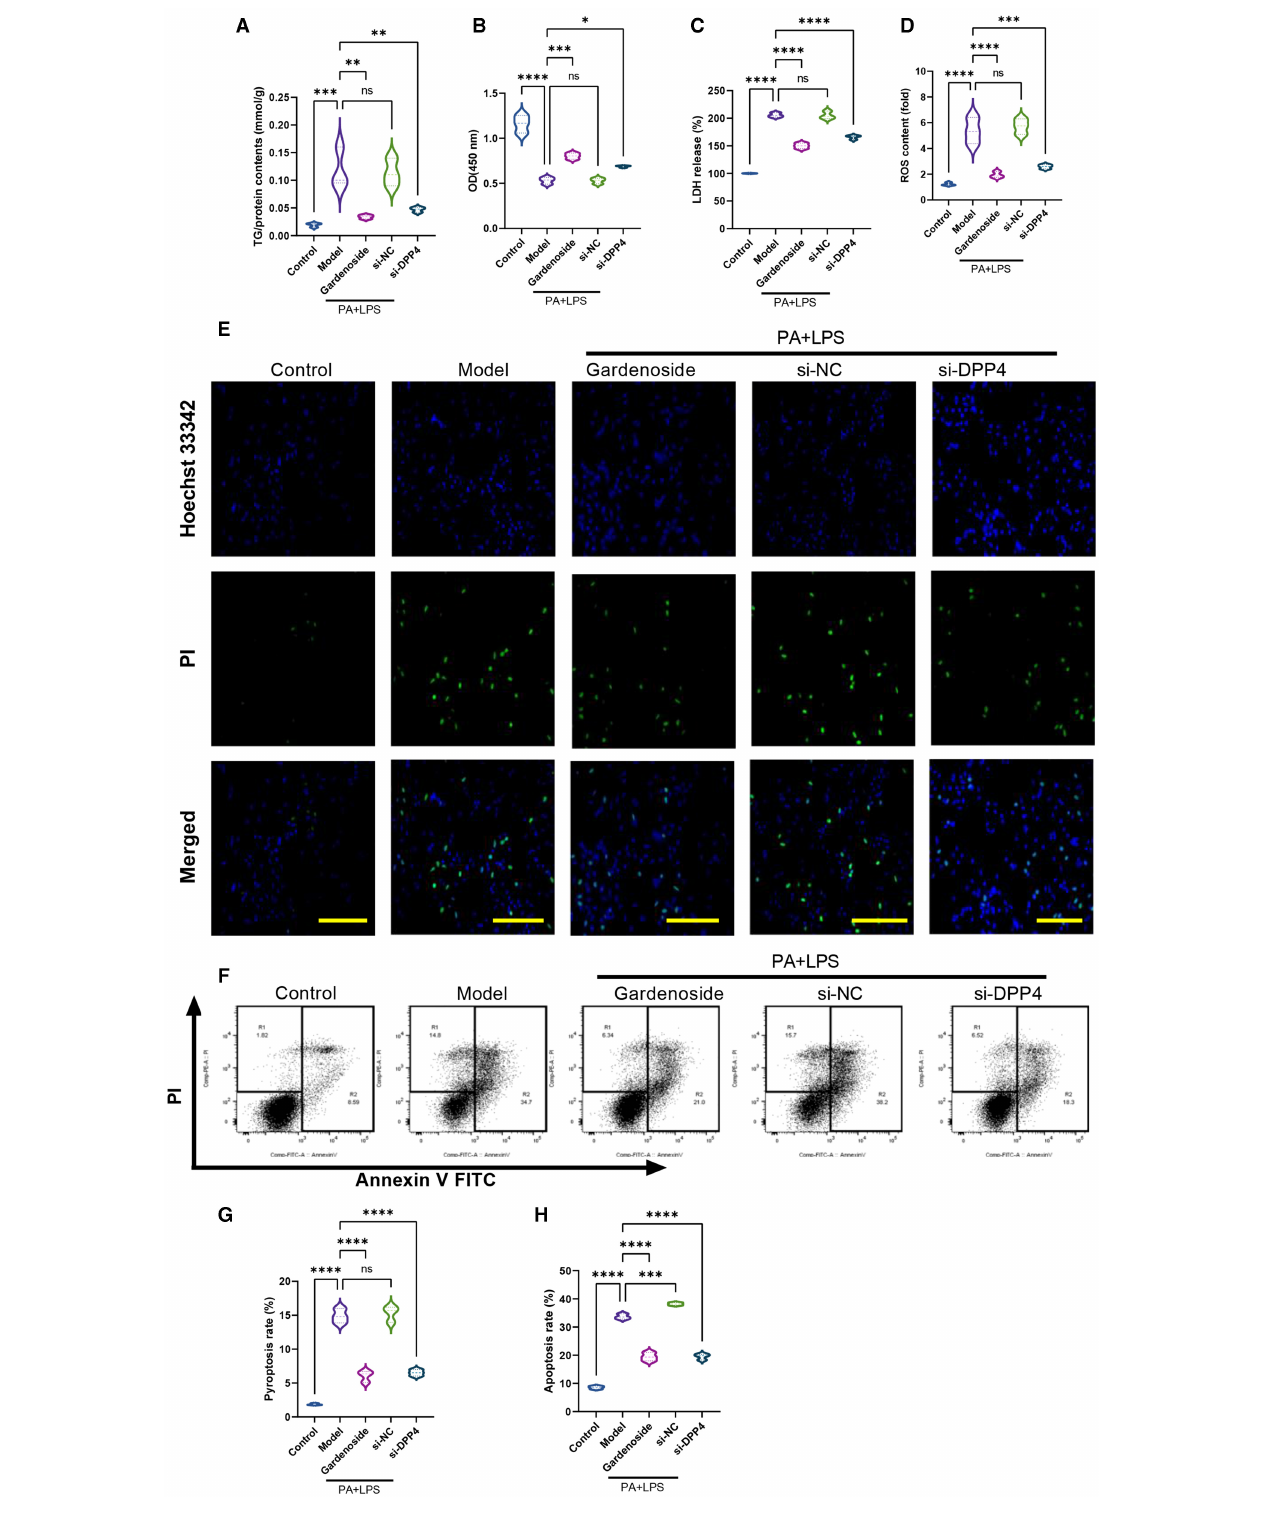
FIGURE 7 | DPP4 silencing mimicked the effect of gardenoside and CTCF silencing on lipid accumulation, intracellular ROS, LDH release, apoptosis and pyroptosis in the cell model of NAFLD. (A) Detection of the TG content in AML cells of indicated groups. (B) Detection of cell proliferation in AML cells of indicated groups.